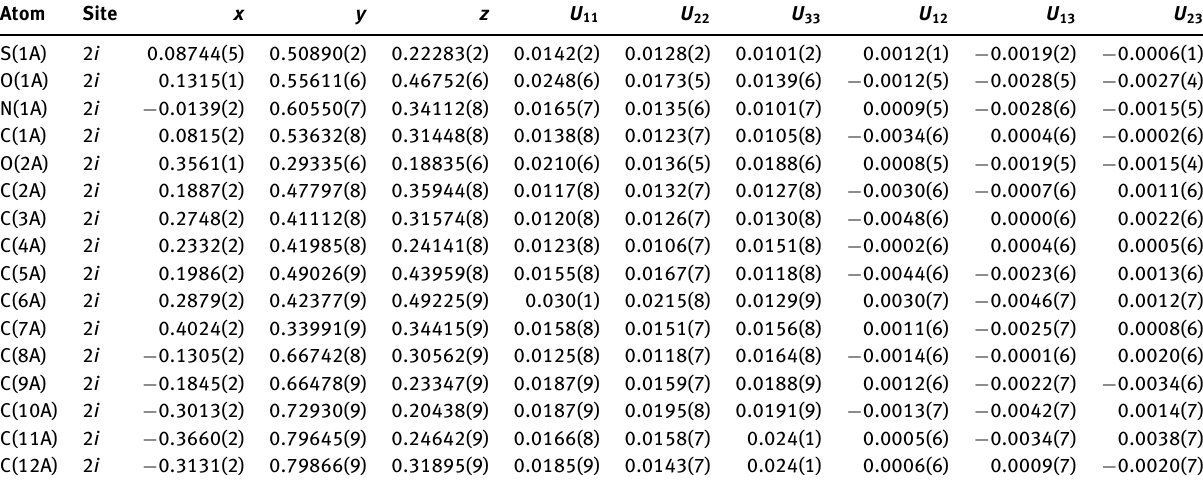
Table 3: Fractional coordinate and displacement